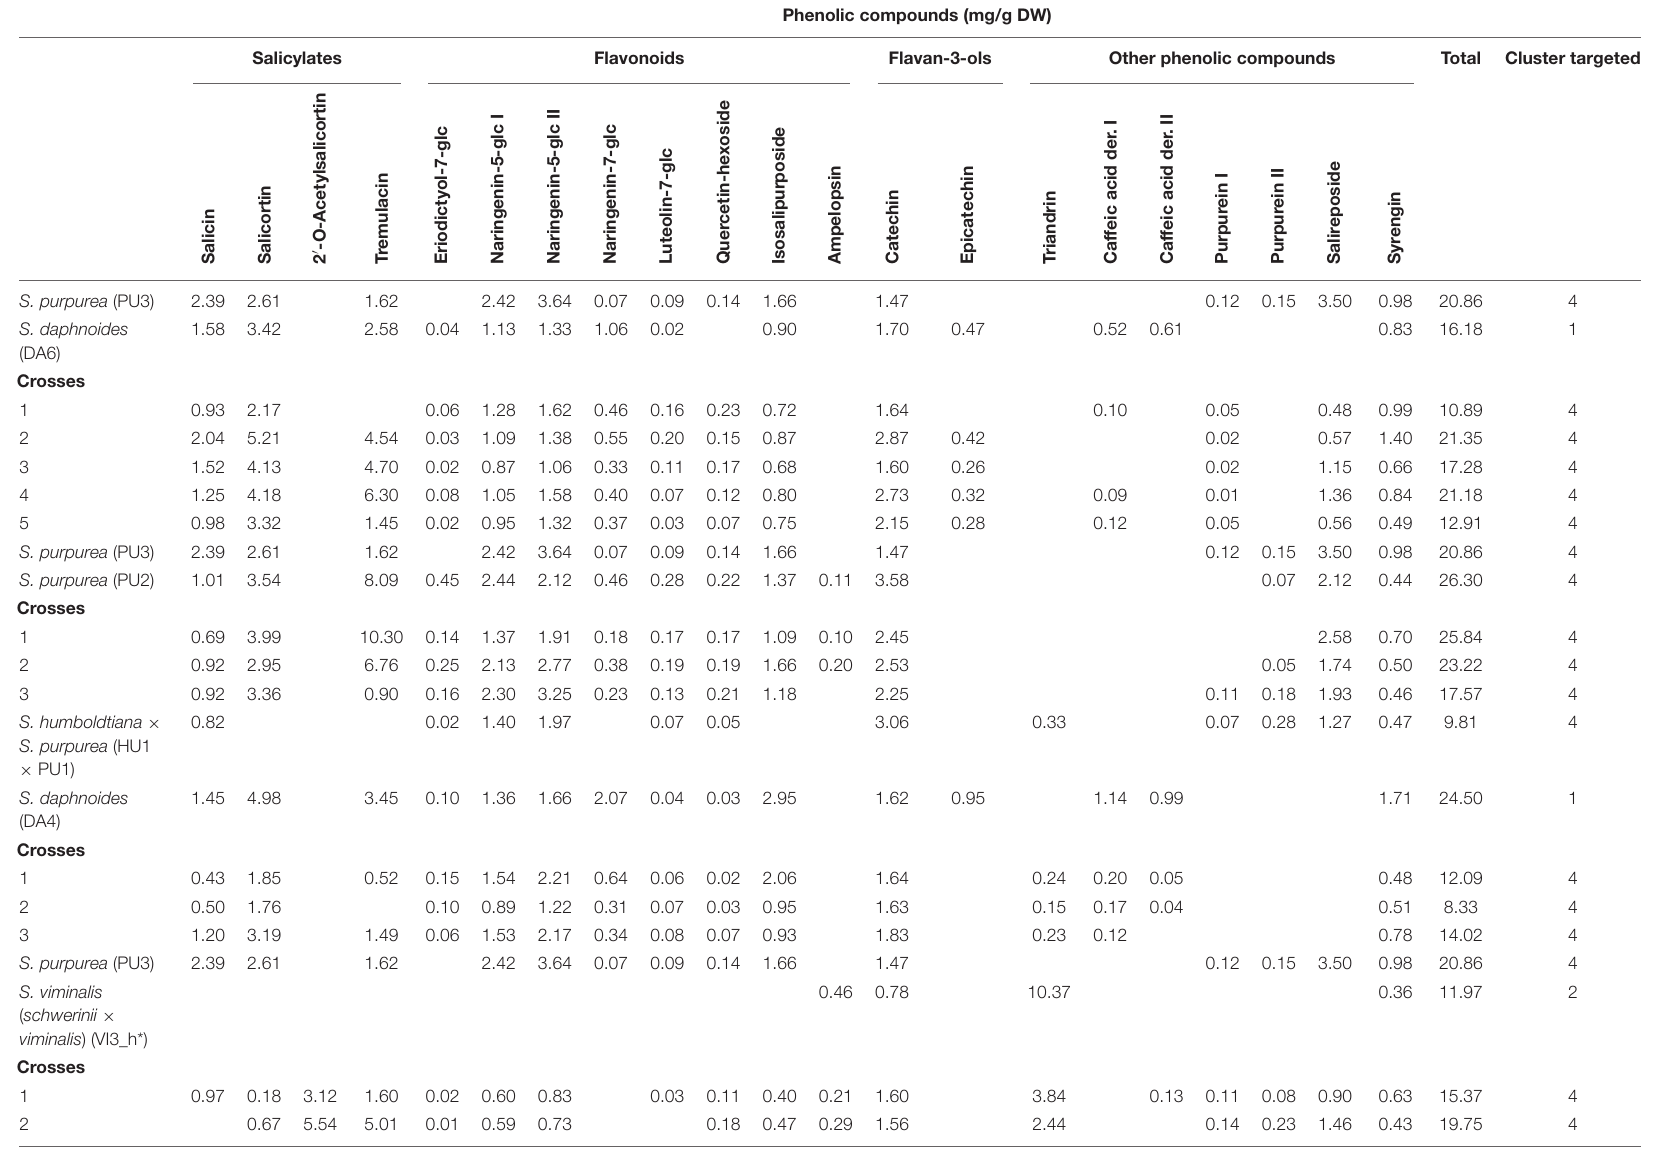
TABLE 4 | Phenolic compound profile of clones of S. daphnoides , S. viminalis , S. purpurea, S. humboldtiana × S. purpurea , and their